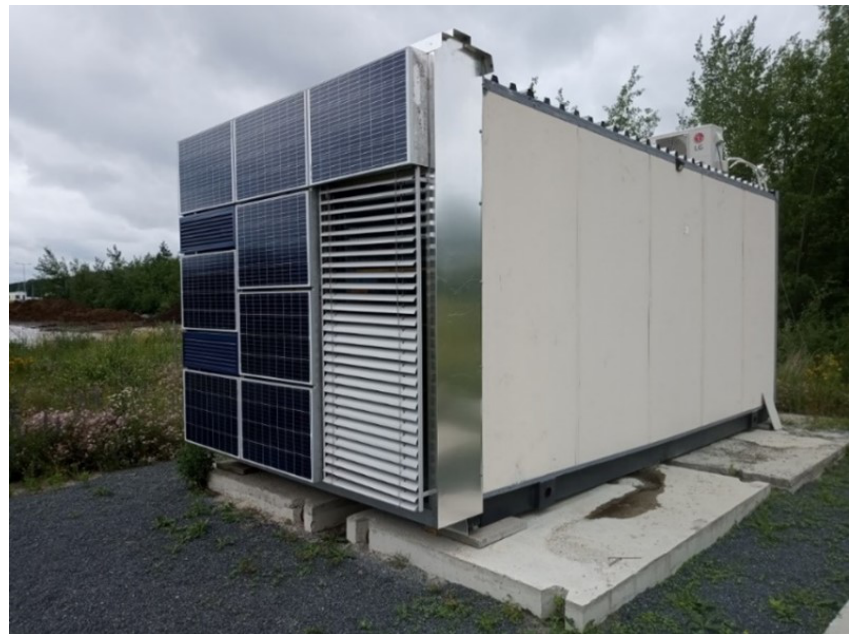
Figure 1. Demonstration façade curtain walling unit deployed at testing